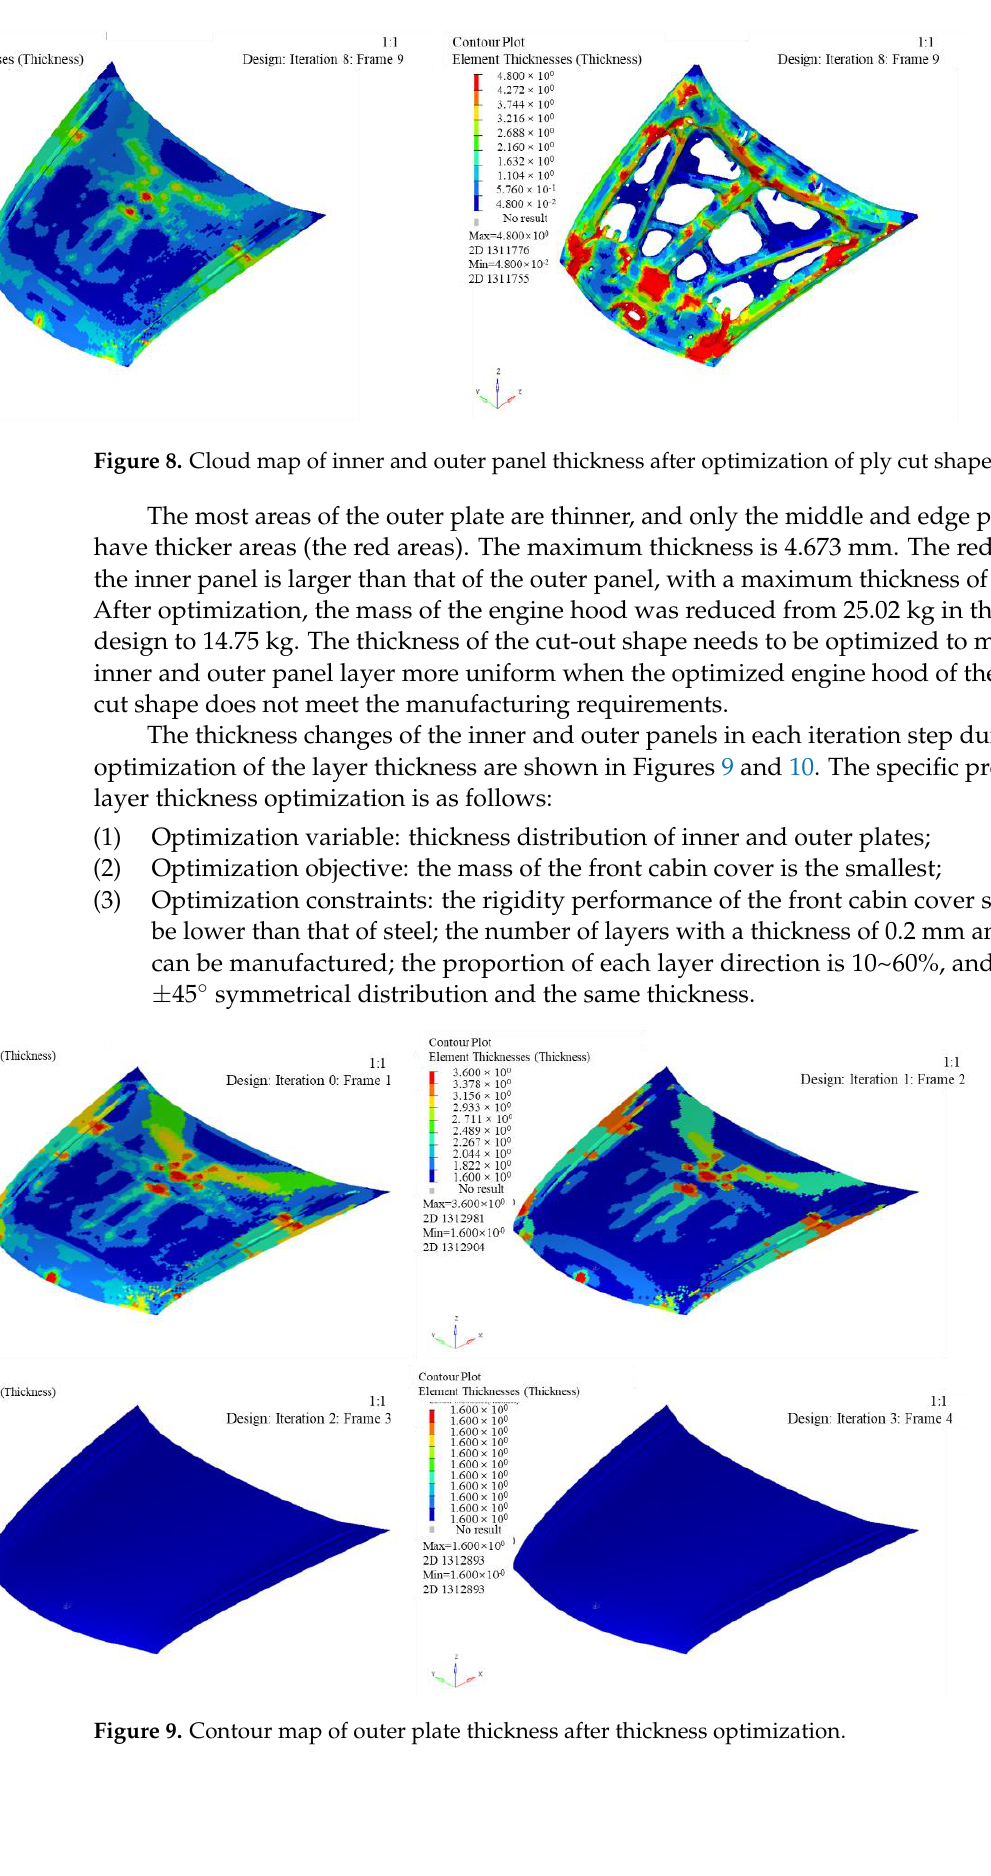
Figure 10. Contour map of inner plate thickness after thickness optimization. The composite materials, which have unique layup orientation and stacking se- quences, have a larger design space than metal materials. The optimization of the layup sequence is carried out based on the results of thickness optimization and only optimizing